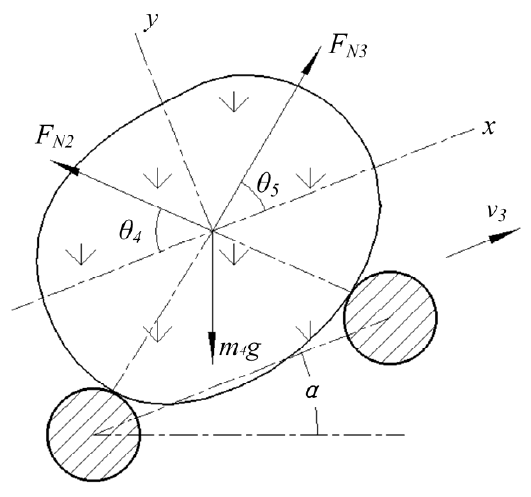
Figure 7. The kinetic analyses of potato tuber during conveying area. The initial speed of the potato falling on the ascending chain was assumed as 0, and the second-stage lifting chain moved backward at a constant speed v 2. The potato tubers went through two phases, the acceleration and uniform speed phase. At the